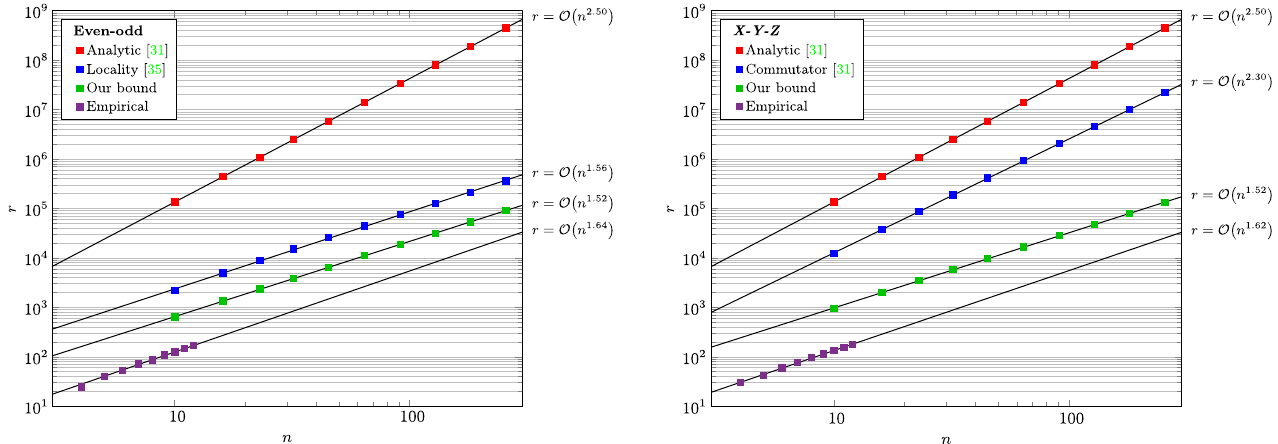
FIG. 3. Comparison of r for the Heisenberg model using the analytic bound (see Proposition F.4 in Ref. [31]), the commutator bound (see Theorem F.11 in Ref. [31]), locality-based bound (see Supplementary Material IV B in Ref. [35]), and our new bounds, Proposition M.1 and Proposition M.2. Error bars are omitted as they are negligibly small on the plot. Straight lines show power-law fits to the data. Note that the exponent for the empirical data is based on brute-force simulations of small systems and thus may not precisely capture the true asymptotic scaling due to finite-size